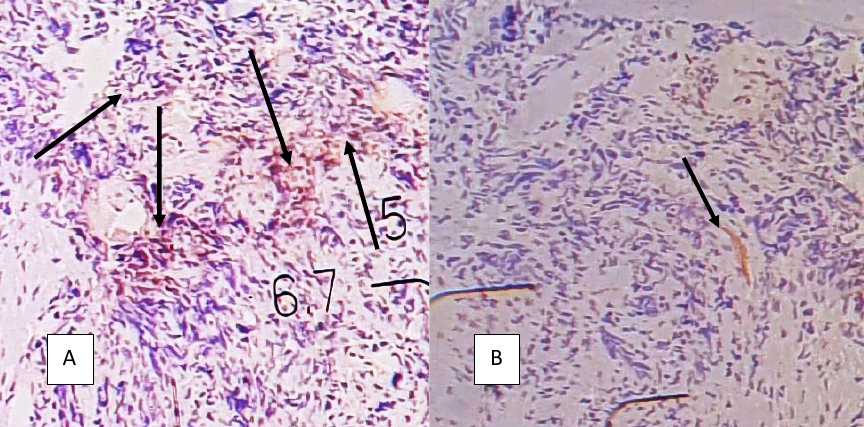
Figure 6. VEGF staining in high-grade serous EOC, magnification 20×. ( A ) High expression: many areas with stained cytoplasm are visible (arrows), ( B ) low expression: single area with stained cells (single arrow).